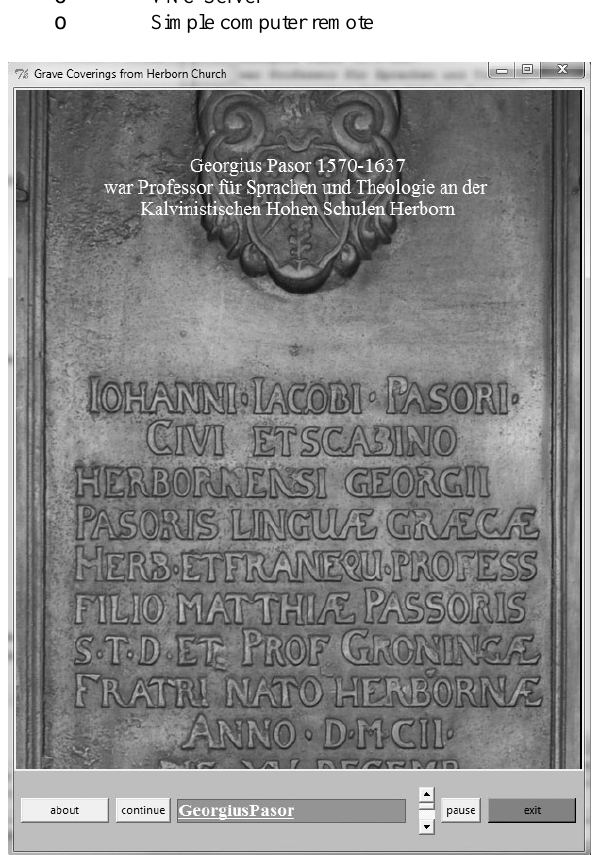
Figure 9: Screenshot of image presentation